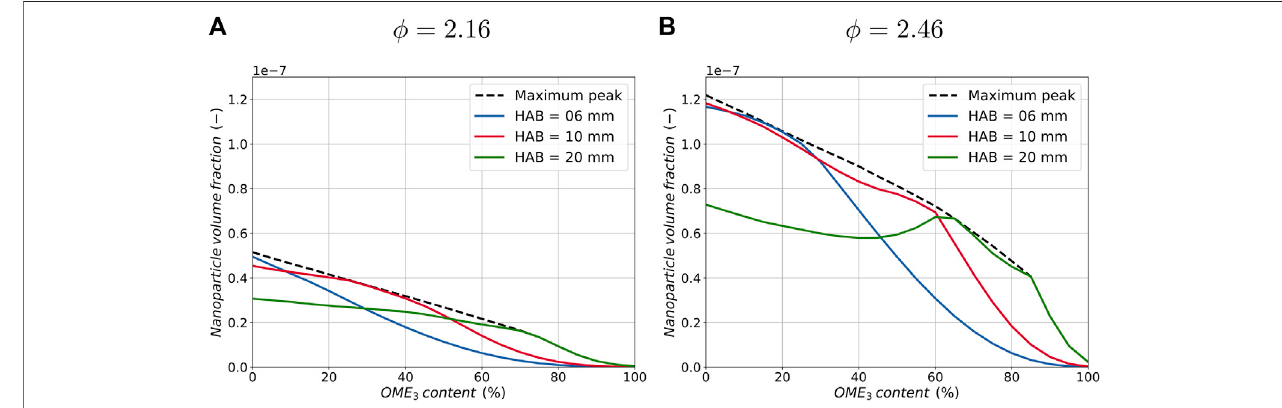
FIGURE 5 | Correlation between nanoparticle volume fraction and blending ratio of OME 3 for three different positions in the fl ame and the maximum peak in the fl ame for an equivalence ratio of ϕ (cid:1) 2.16 (A) and ϕ (cid:1) 2.46 (B) .